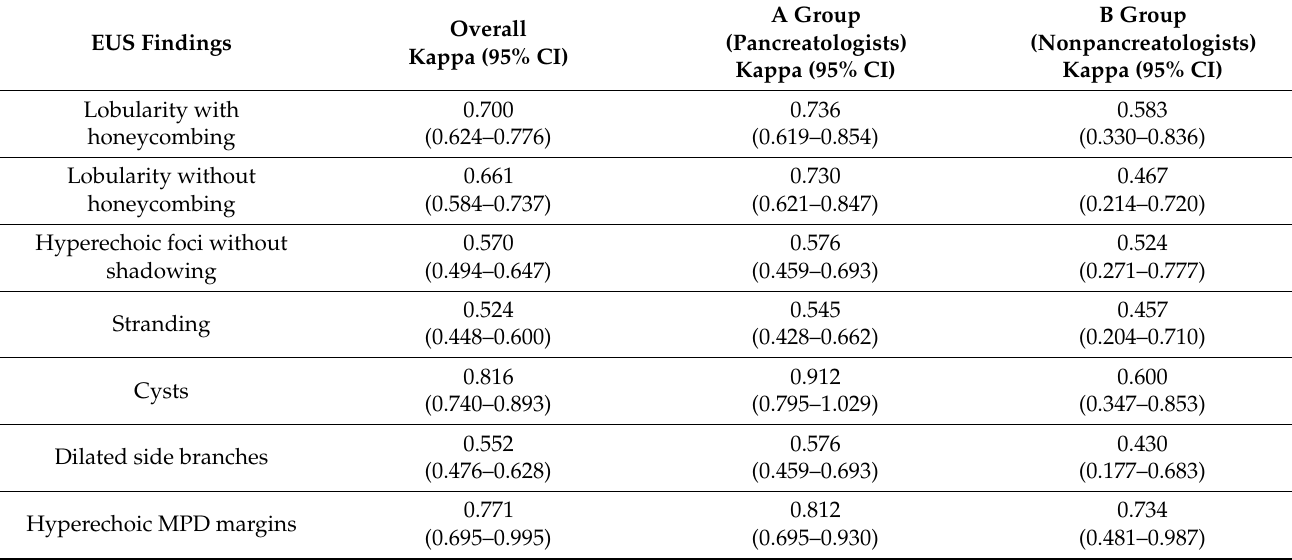
Table 2. Interobserver reliability of each EUS finding in DCECP2009.